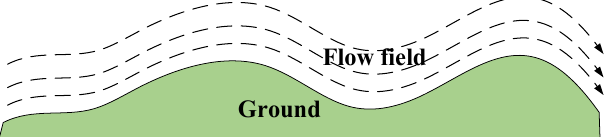
Figure 2. Schematic diagram of the Coanda effect.